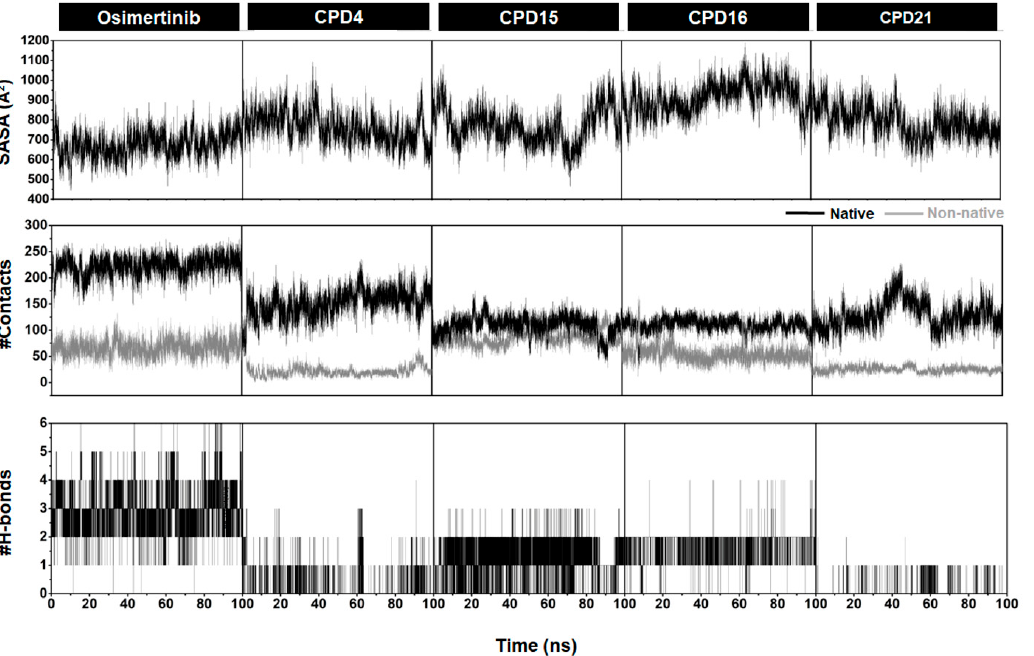
Figure 5. Plots of SASA and contact atoms counted within the 5.0 Å from the ligand as well as number of H-bonds by setting two criteria as follows: (1) the distance between the hydrogen bond donor (HD) and hydrogen acceptor (HA) of ≤ 3.5 Å (2) the angle ≥ 120°.